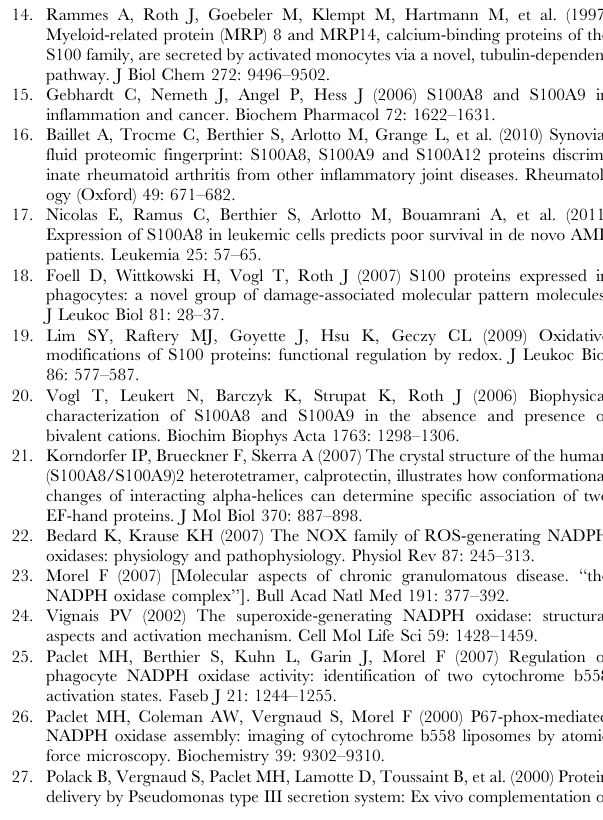
Table S2 Evaluation of EBV-B lymphocytes viability incubated with Pseudomonas aeruginosa by Lactate Dehydrogenase (LDH) activity. LDH activity was evaluated in the incubation medium after 90 min incubation of EBV-B lymphocytes with Pseudomonas aeruginosa or not. Unit represents the number of m mol of substrate transformed per min in 200 m l of contact